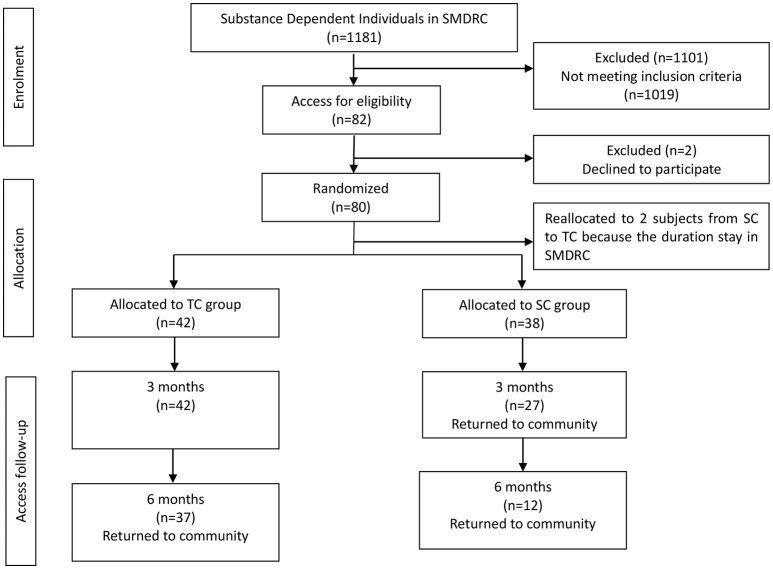
Flow diagram of the intervention progress through the phases of the two groups.